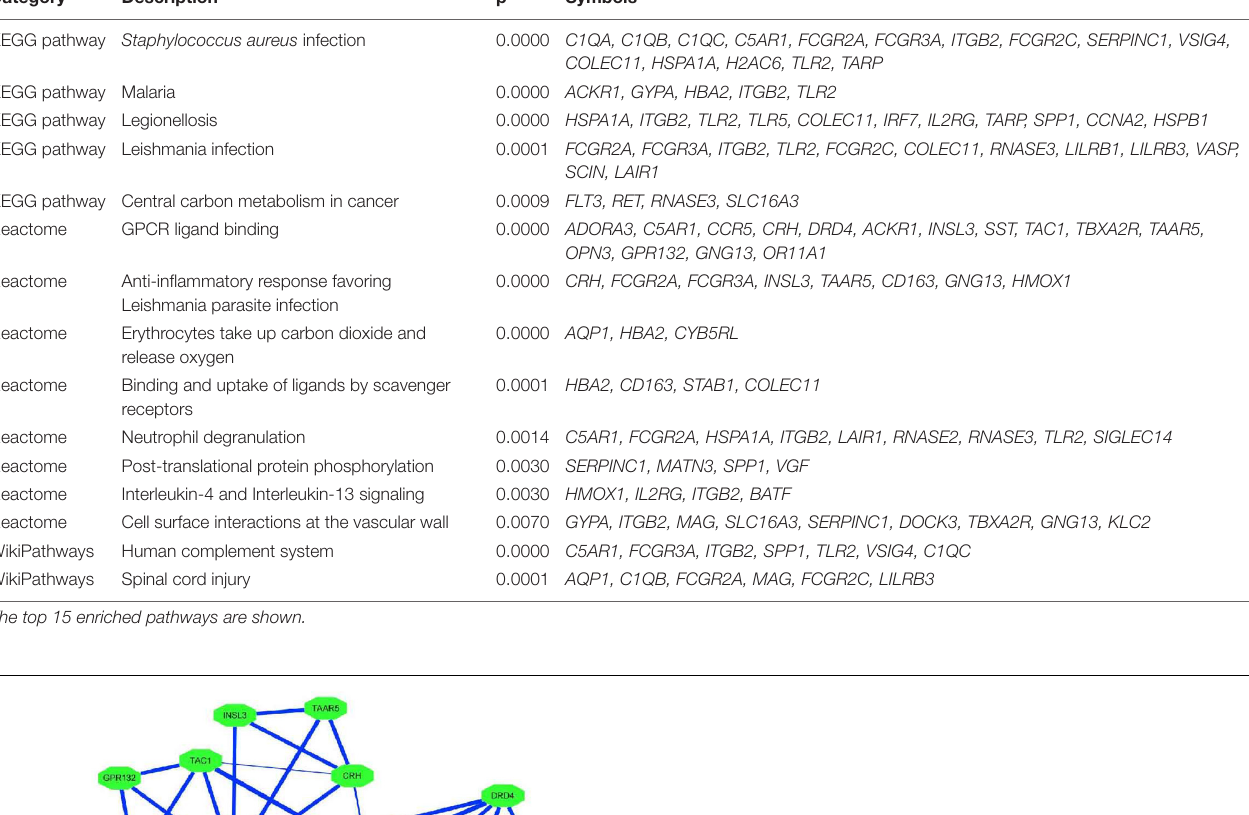
TABLE 3 | Molecular pathway enrichment analysis of the overlapping differentially expressed genes in frontal cortex and temporal cortex in vascular dementia. Category